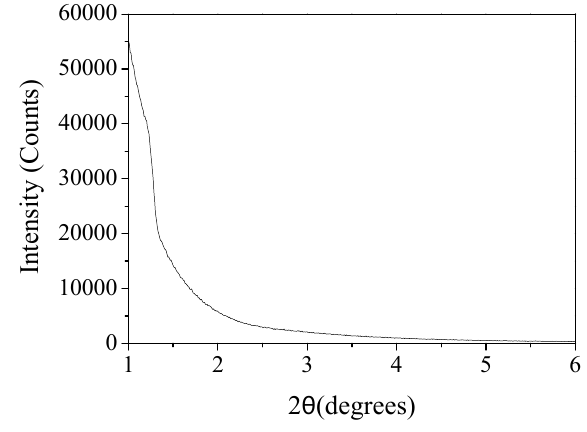
Figure A1. Low ‐ angle XRD pattern of mesoporous silica.